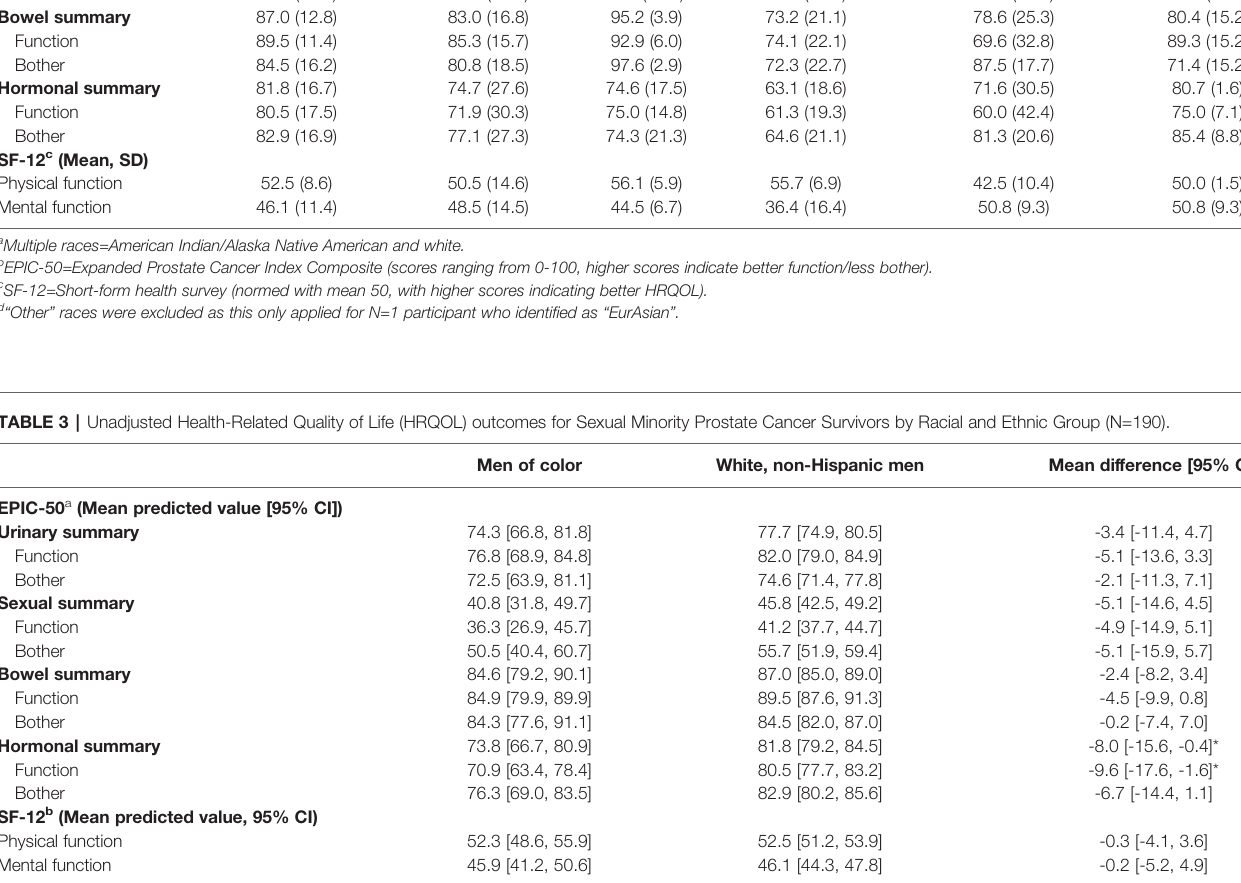
TABLE 2 | Descriptive Statistics of Health-Related Quality of Life (HRQOL) outcomes for Sexual Minority Prostate Cancer Survivors by Racial and Ethnic Group (N=189). White, non-Hispanic (N=167) EPIC-50 b (Mean, SD)